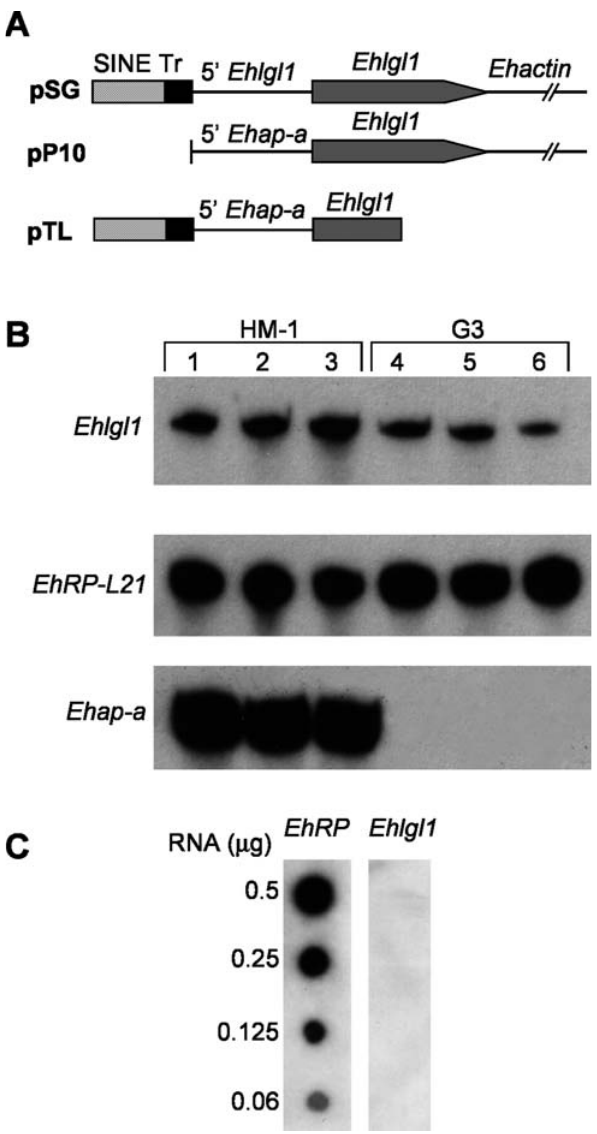
Figure 8. Additional Plasmid Constructs Tested for Their Silencing Capabilities (A) Diagrams of plasmid pSG in which the truncated SINE 1 and the T-rich sequences were ligated upstream to the Ehlgl1 promoter and ORF regions. Plasmid pP10 has the SINE1 sequences removed from the Ehap- a promoter region. Plasmid pTL contains a truncated segment of the Ehlgl1 gene without the 3 9 regulatory region. Plasmid constructs can be compared to plasmid pB33 in Figure 2. (B) Northern blots of RNA extracts of trophozoite transfectants. Probes used as indicated. Lanes: 1, untransfected HM-1:IMSS; 2, HM-1:IMSS transfected with pSG; 3, HM-1:IMSS transfected with pP10; 4, G3; 5, G3 transfected with pSG; 6, G3 transfected with pP10. (C) Dot blot of RNA extracts from G3 trophozoites transfected with plasmid pTL and hybridized with probes for either EhRP-L21 or Ehlgl1. DOI: